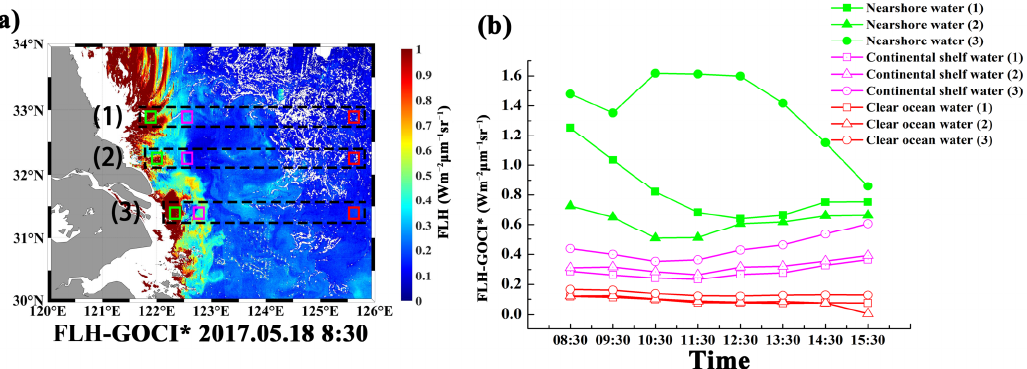
Figure 12. Hourly FLH changes of three water bodies on 18 May 2017. (The framed area (1–3) in panel ( a ) is the selected area, the green frame is the nearshore water area, the purple frame is the continental shelf water area, and the red frame is the clear ocean water area.) and ( b ) is the hourly FLH changes of three water bodies on 18 May 2017.